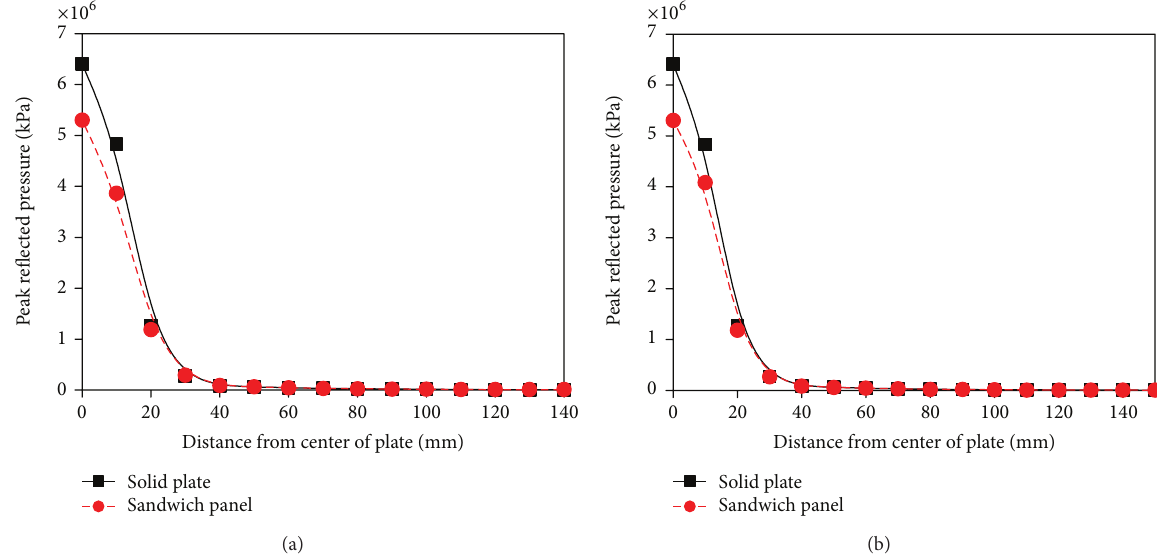
Figure 12: Spatial distributions of peak reflected pressure near the FSI surface along (a) the direction perpendicular to corrugations and (b) the direction parallel to corrugations.